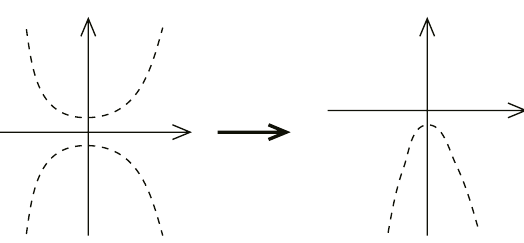
Figure 12 . Left: states in the Landau-Zener model, when two states do not cross. Right: the situation is shown for the decoupled (Schrödinger) equation. The left is simply showing the diagonal elements, not the adiabatic